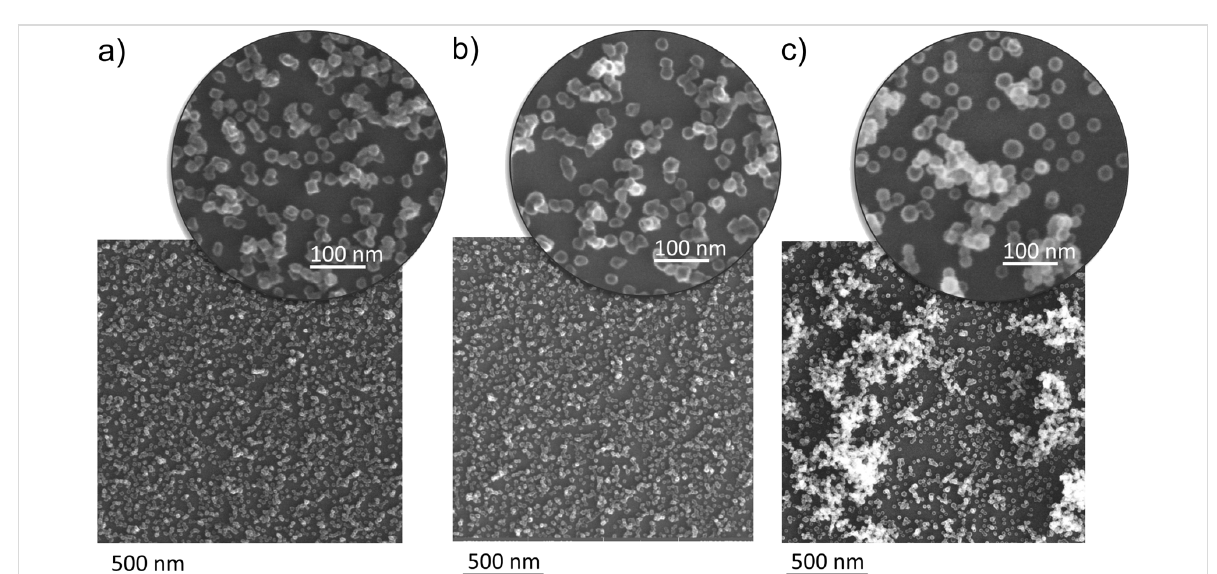
Figure 3: SEM images of samples of (a) type 1, (b) type 2 and (c) type 3. Round inserts show high-magnification images for every